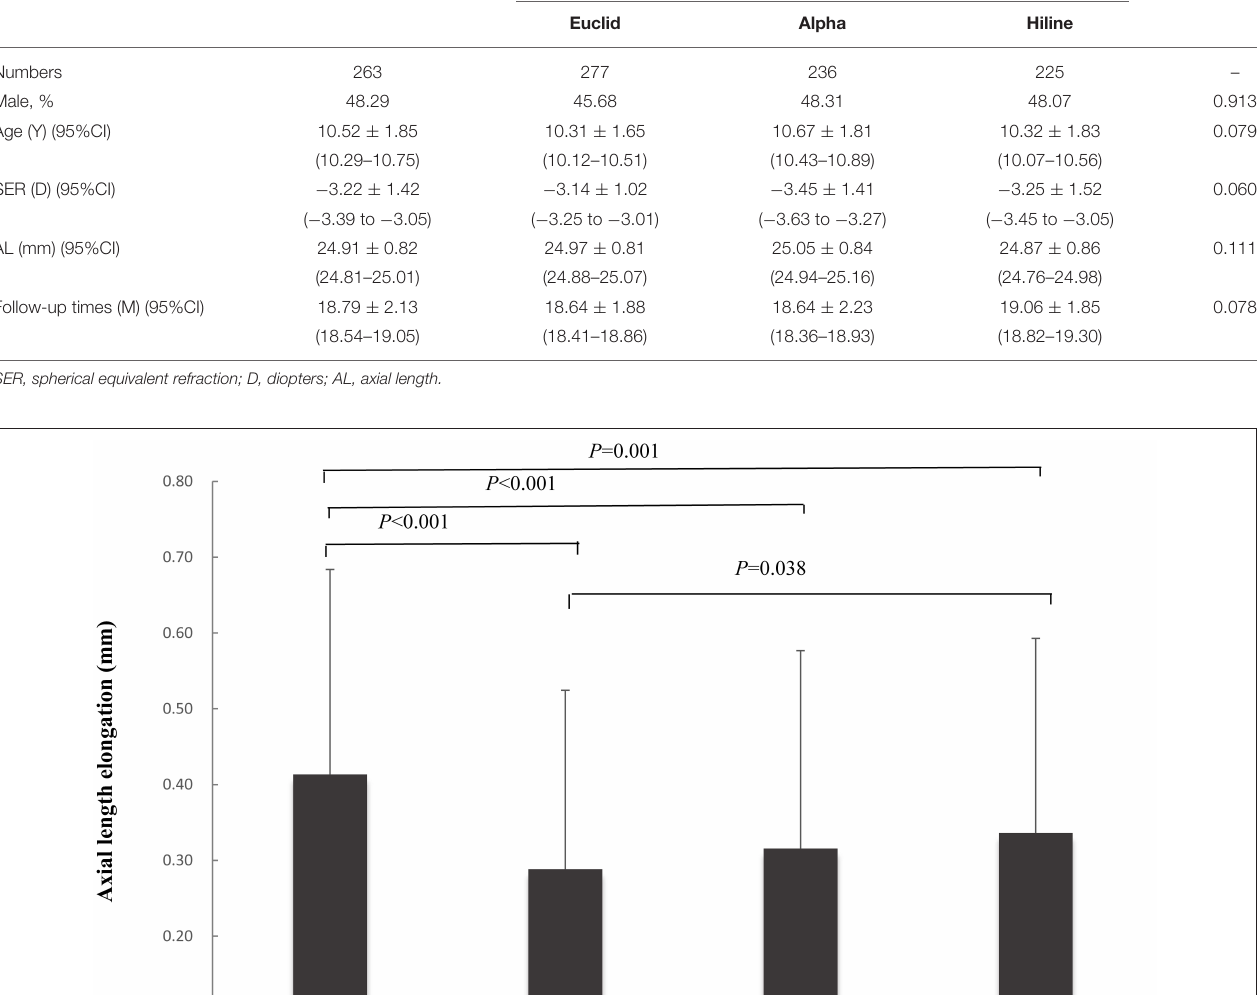
± 0.02 mm was greater than that in the Alpha group ( P < 0.001), and 0.08 ± 0.02 mm was greater than that in the Hiline group ( P = 0.001). The AL elongation in the Hiline group was 0.05 ± 0.02 mm greater than that in the Euclid group ( P = 0.037). There was no significant difference between the Alpha group and the Euclid group ( P = 0.249) or between the Hiline group and the Alpha group ( P =